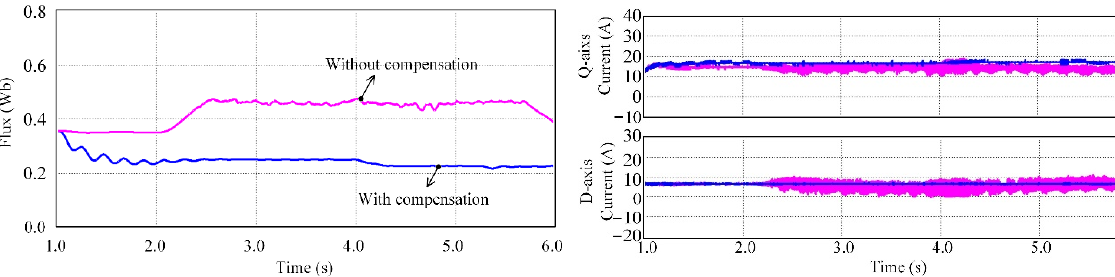
Figure 10. Rotor flux, d-axis, and q-axis current comparative waveforms at 3000 rpm with a 15 Nm load.